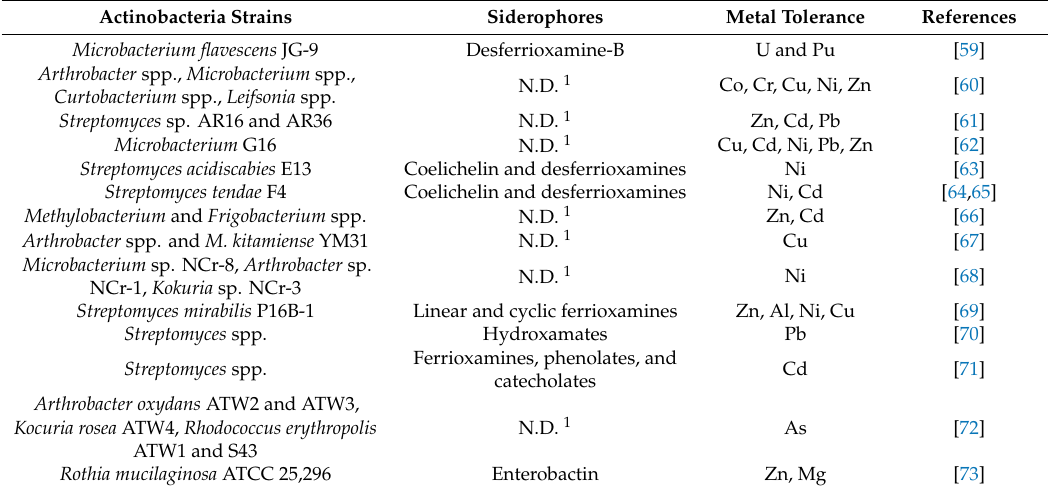
Table 1. Siderophores produced by Actinobacteria as metal(loid) chelating